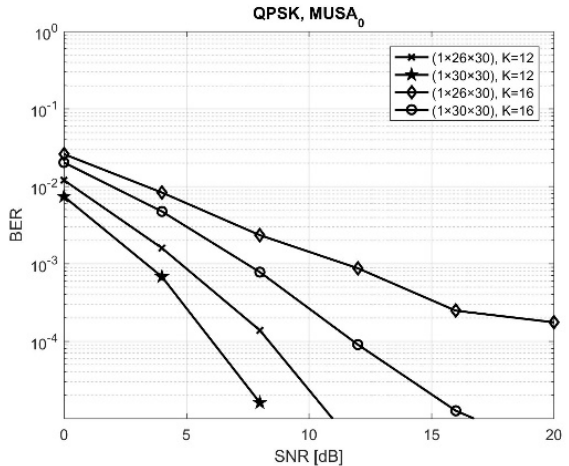
Figure 7. BER vs. SNR for a (1 × 26 × 30) and (1 × 30 × 30) MIMO configuration, QPSK modulation, MUSA 0 with 12, 16 active users.